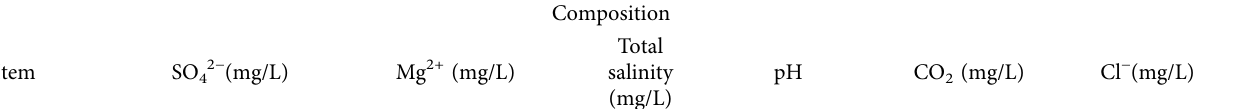
Table 4: Main indicators of water composition